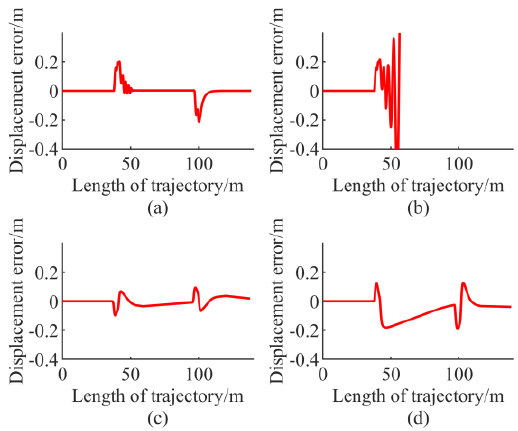
Figure 10. The displacement error when velocity is 3 m/s. ( a ) LMPC. ( b ) LEMPC. ( c ) NMPC. ( d ) NEMPC.